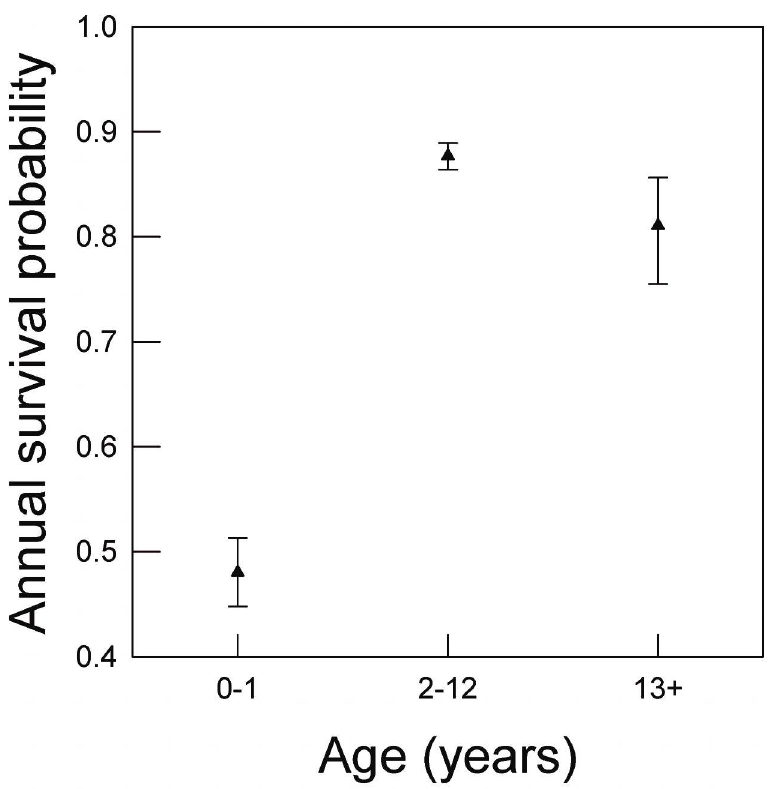
Fig 1. Age-class specificapparentannual range-wide survivalof snailkitesin Florida,modifiedfrom Reichertet al. [16]. Results fromprevious analyses reveal that adult survivaldeclinessignificantlyin snail kites beginningat age 13. Estimatesare based on modelingencounter historiesof 2084 known age individuals from1992–2008 using an extension of the Cormack-Jolly-Sebermodelfor open populations accountingfor age-class specific variationin survival[16].Errorbars represent 95% confidenceintervals.